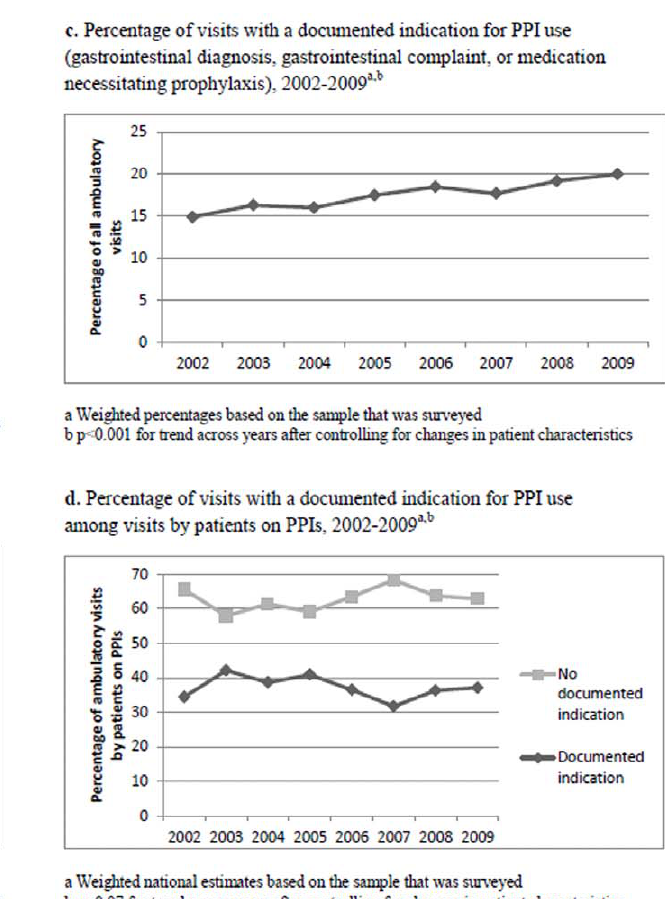
Figure 2. Changes in possible reasons for increased PPI use.